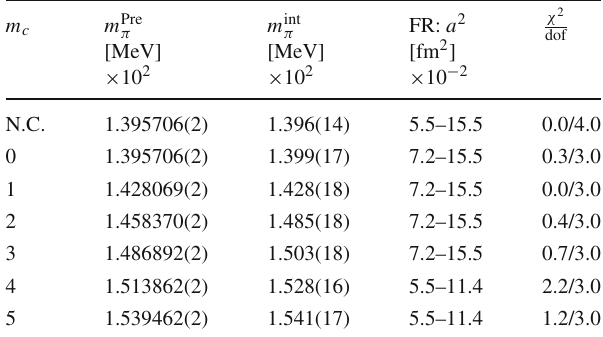
Table 20 The prediction of the pion mass m Pre π , interpolated results of the pion mass m int π , and fitting results